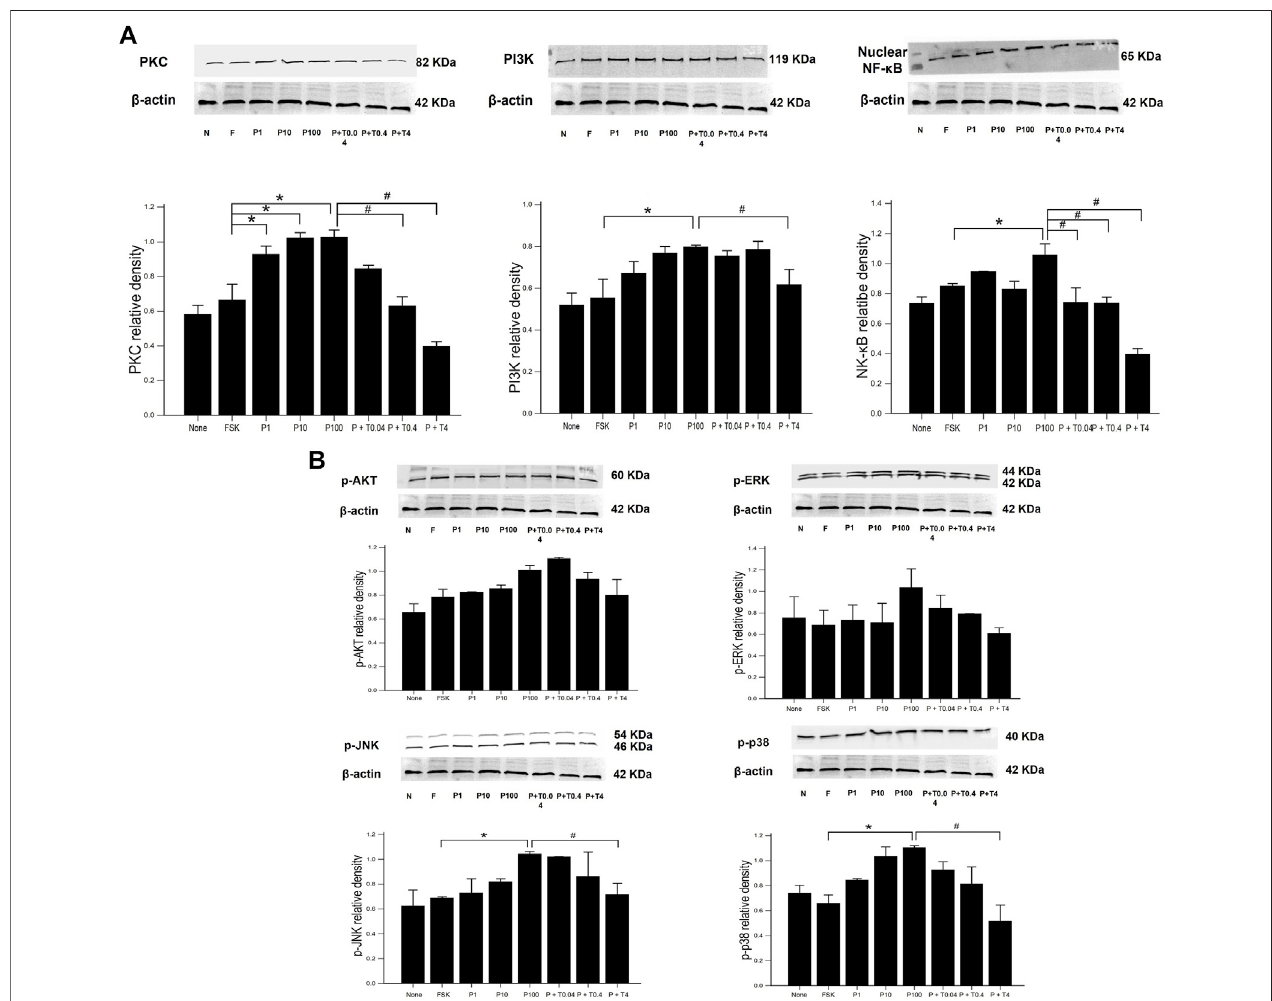
FIGURE4| Western blotanalysisofneuronalin fl ammatory signalon50B11cells. Westernblotimages showingtherelativeprotein expressionofsignalingprotein, including (A) PKC, PI3K, NF- κ B, and (B) phospho-MAPK (ERK, JNK, and p38) relative to that of β -actin. ImageJ-quanti fi ed densitometry. Data were presented as the medianandinterquartilerange(IQR)andanalyzedusingtheKruskal-WallistestfollowedbytheConover test( n =3pergroup). * p < 0.05comparedtotheFSK; # p < 0.05 compared to the P100.